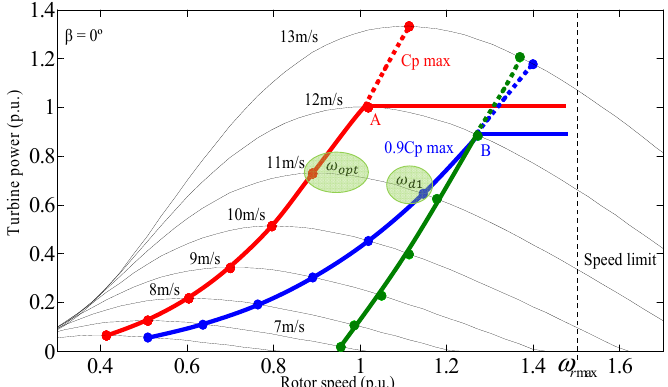
Figure 7. Turbine deloaded and maximum power curves.